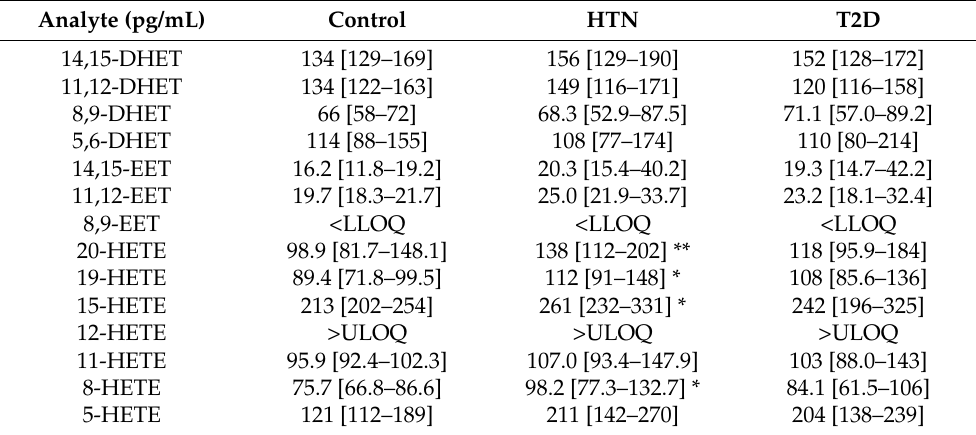
Table 3. Oxylipin concentrations according to physio(patho)logical status.